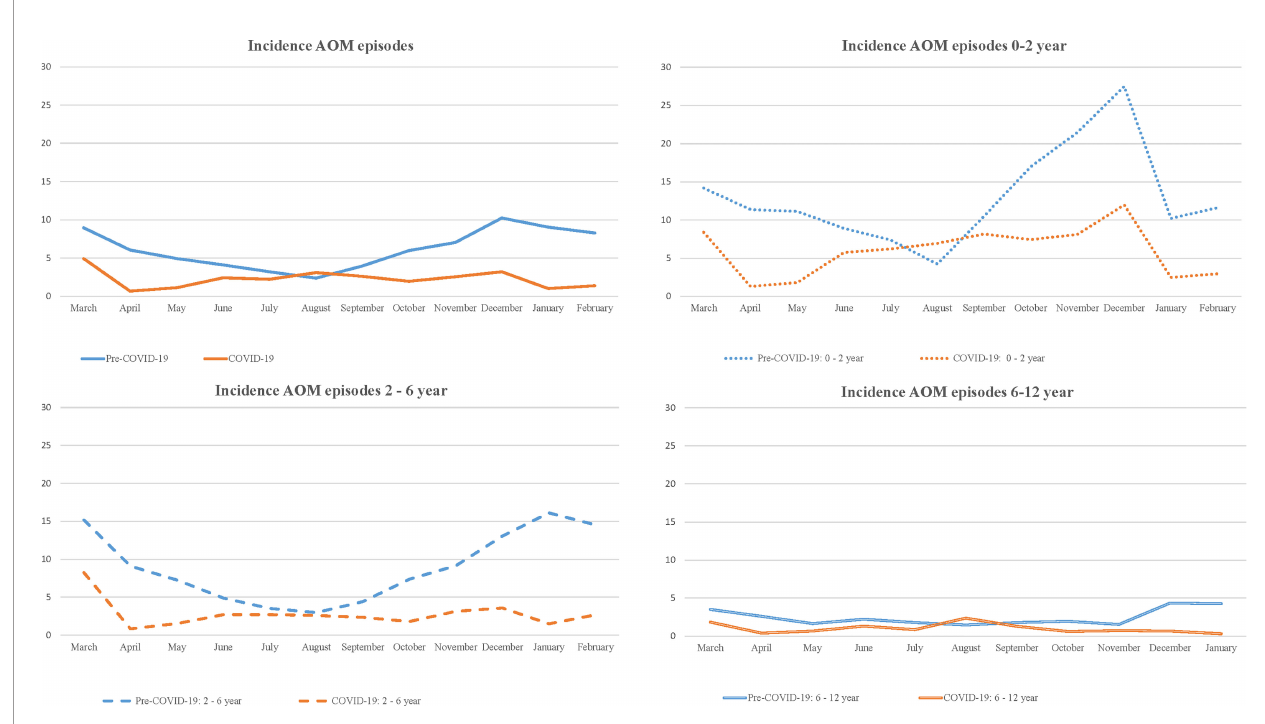
FIGURE 1 | Incidence of AOM episodes per 1,000 childmonths (total and according to age) pre-COVID-19 era and COVID-19